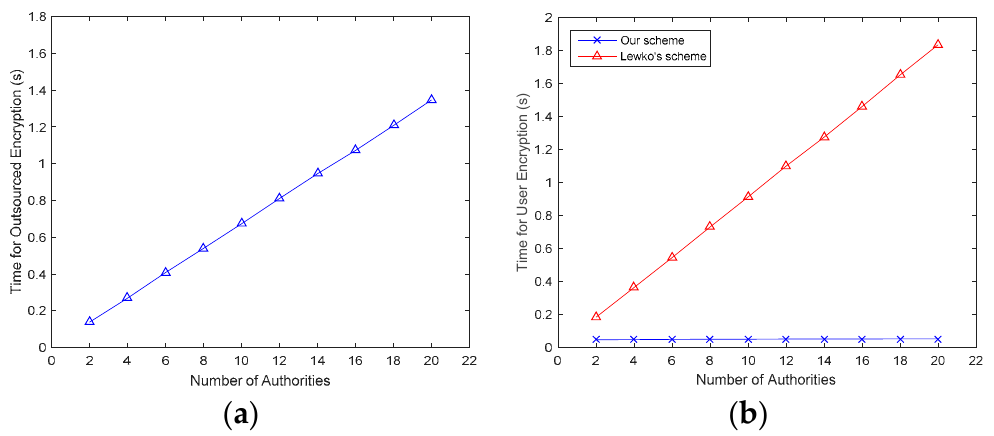
Figure 3. Comparison of encryption time with different number of authorities. ( a ) Encrypt_out time; ( b ) Encrypt_user time.